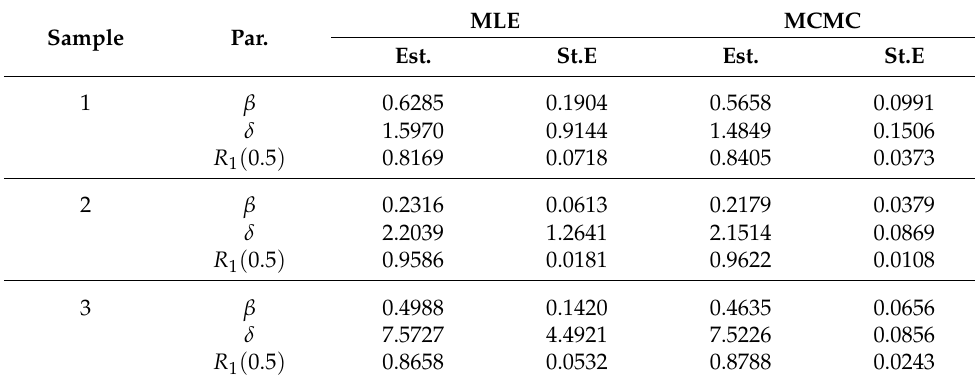
Table 4. Point estimates of β , δ and R 1 ( t ) from insulating fluid